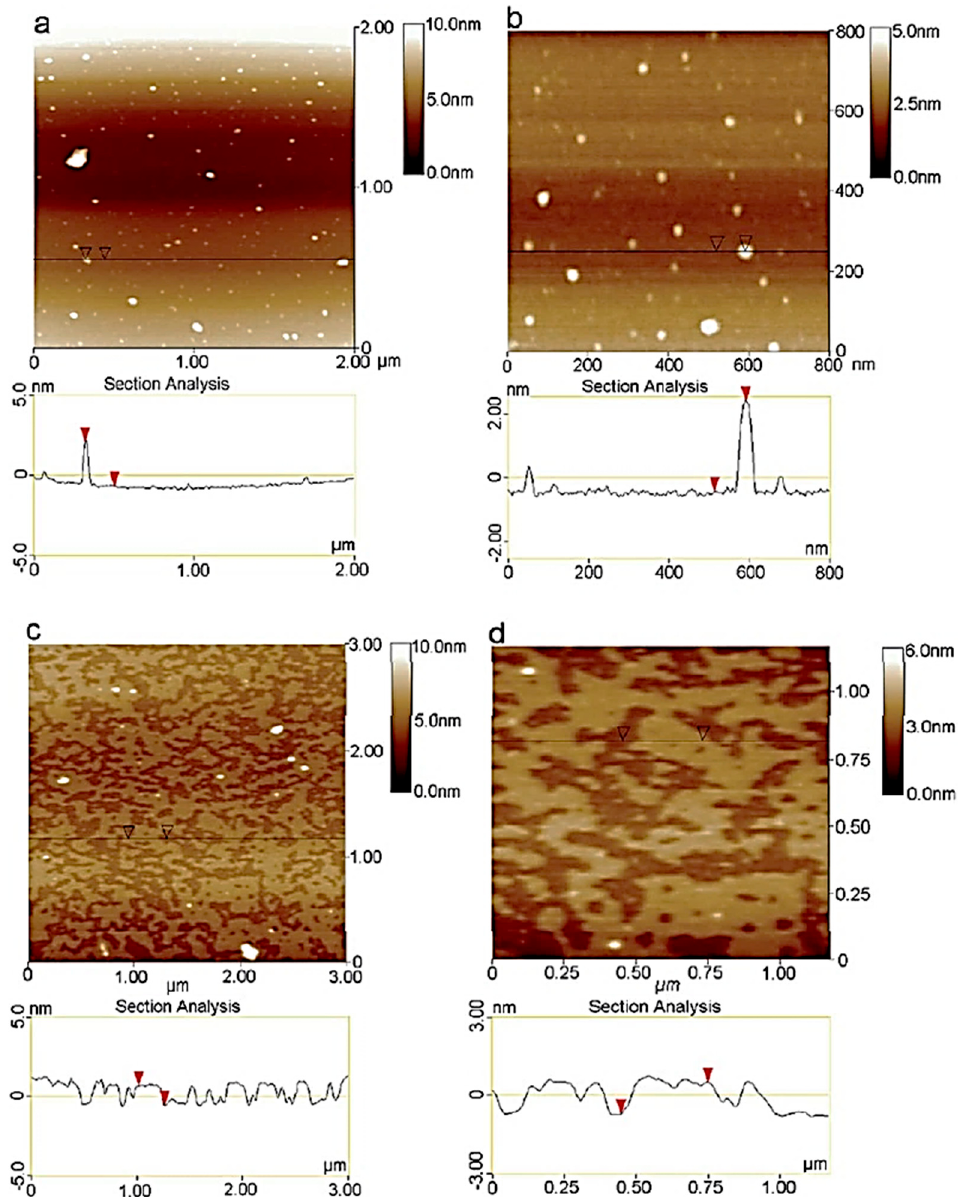
Figure 11. AFM micrographs of ( a ) multilayer Gp films (2 × 2 mm), ( b ) multilayer Gp films (0.8 × 0.8 mm), ( c ) single layer Gp films (3 × 3 mm), and ( d ) single layer Gp films (1.25 × 1.25 mm). Reprinted